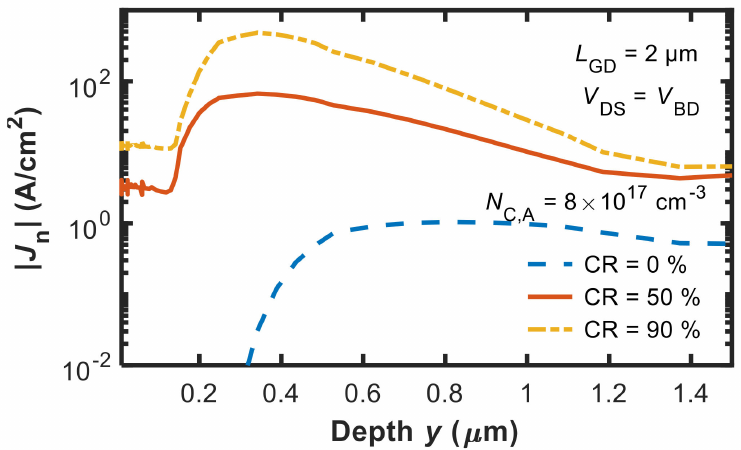
Figure 6. Modulus of the electron current density (| J N |) as a function of the device depth along a cutline taken in the middle of the gate contact for CR = {0, 50, 90}% at the same N C,A value (8 × 10 17 cm − 3